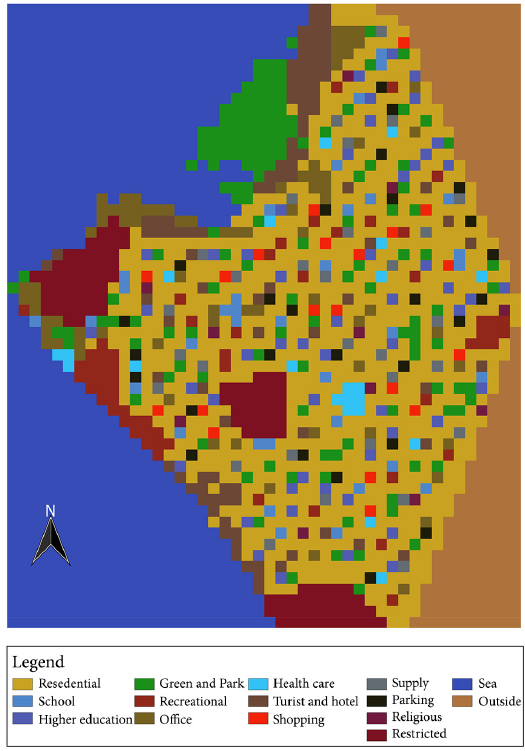
Figure 10. A land-use map from Zanzibar city (case study area), when the objective function of maximizing compatibility is prioritized (selecting point 3 from Figure 9)